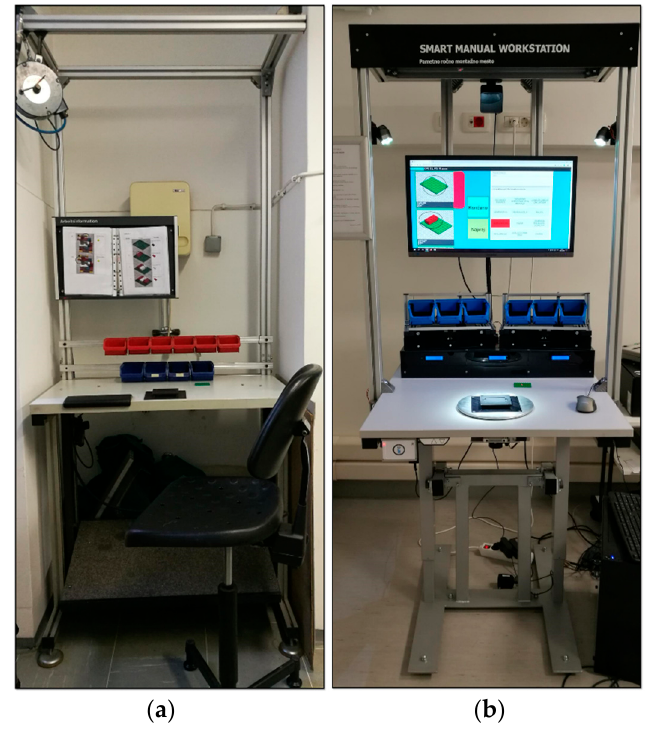
Figure 7. ( a ) Traditional assembly workstation; ( b ) smart assembly workstation.